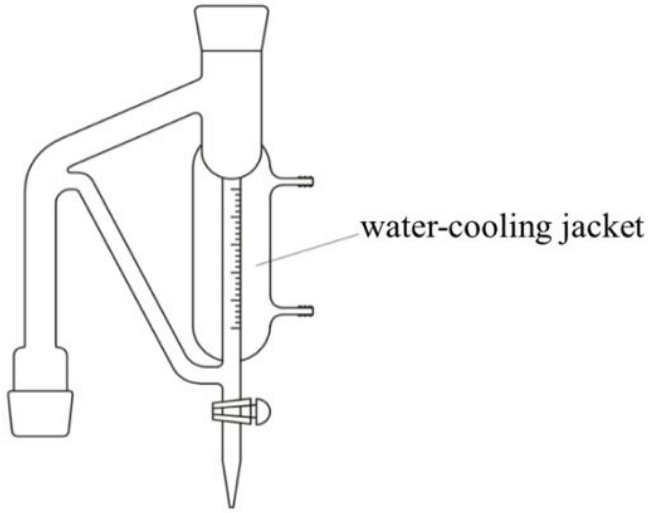
Figure 1. Homemade essential oil extractor.